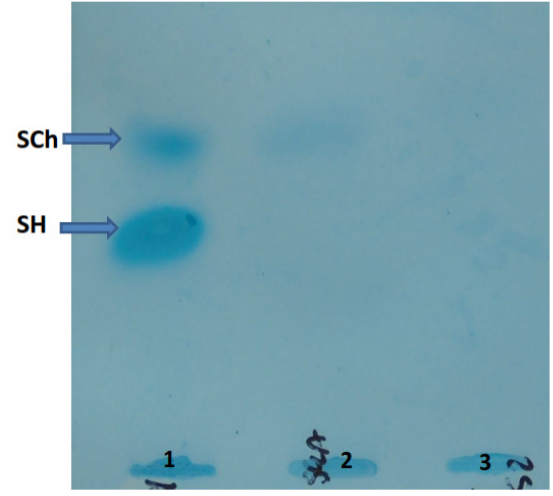
Figure 4. Picture of glycosaminoglycans (GAGs) after electrophoresis on cellulose acetate strips. GAGs were isolated from urine sediment, electrophoresed on cellulose acetate strips, and visualized with alcian blue staining. Path 1—patient with MPS III, Path 2—in patient described here; only a slight band of SCh is visible, Path 3—healthy donor. SCh—chondroitin sulphate, SH—heparan sulphate.